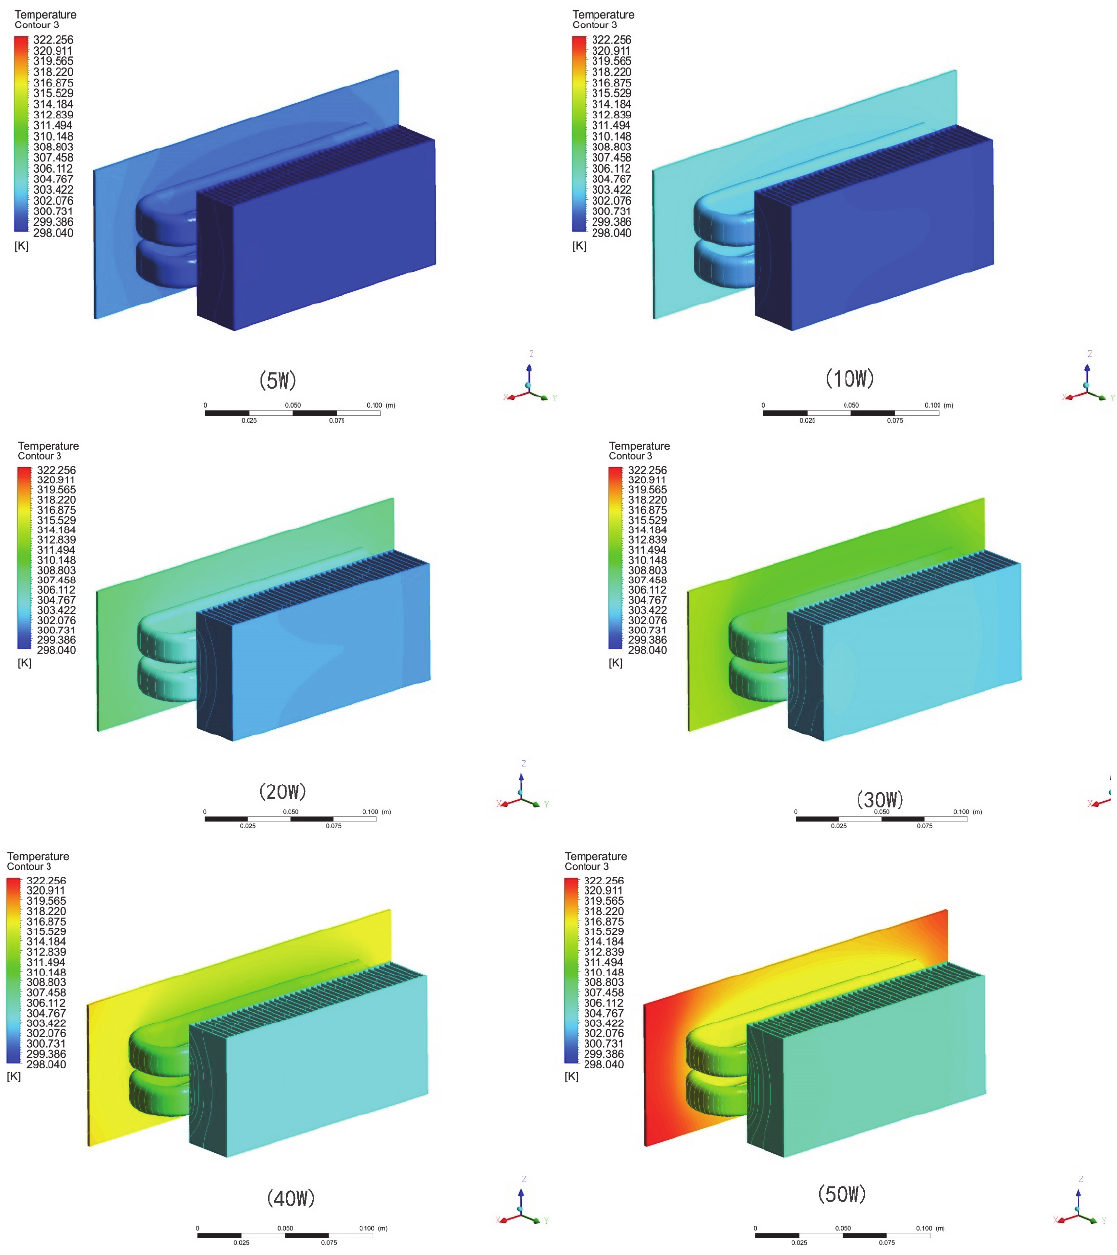
Figure 11. Temperature contours for the heat sink at different inputs. The temperature recorded in Table 5 is the steady-state temperature T e of the double THPs heat sink under experiment and simulation. As can be seen in Table 5, the experi- ment results and simulation results are compared in terms of the temperature outside the evaporator. The maximum temperature difference between the observed and simulated values of the heat sink was 3.53%; therefore, the experiment results are